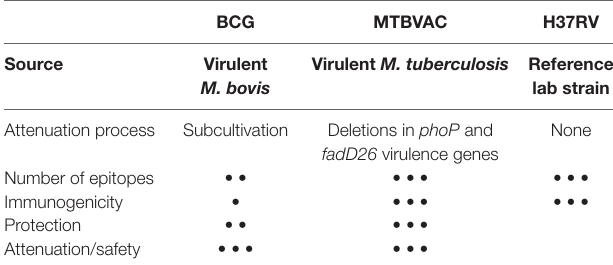
TABle 1 | Comparison of Bacille Calmette-Guérin (BCG), MTBVAC, and H37Rv properties. BCG MTBvAC